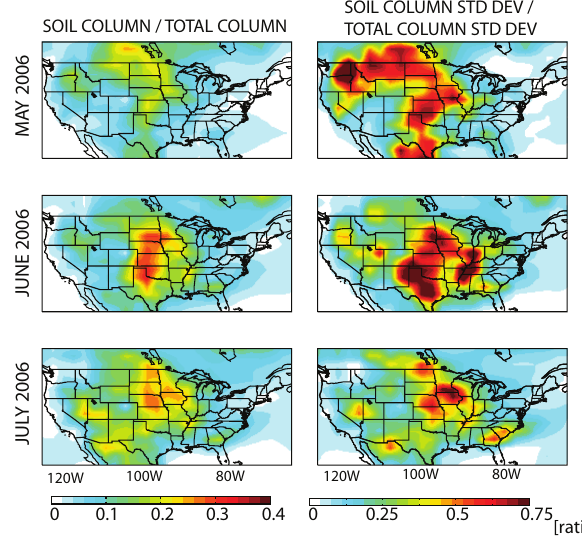
Fig. 2. Simulated contribution of soil NO x emissions to the monthly mean (left) and standard deviation (right) in tropospheric NO 2 col- umn over the United States using GEOS-Chem. The soil column is defined as the difference in the troposphereic NO 2 column between a simulation with and without soil NO x emissions over the region 20–65 ◦ N, 135–70 ◦